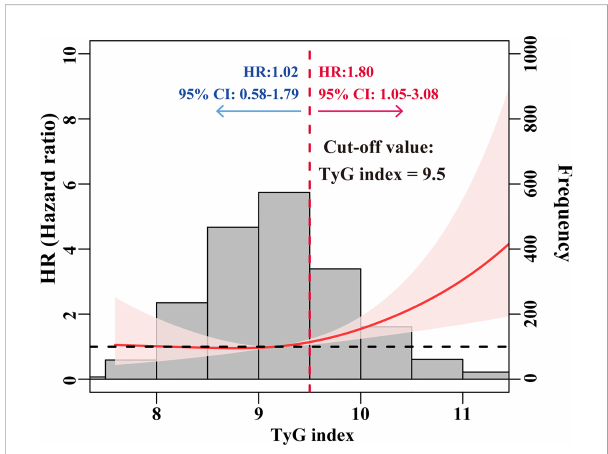
FIGURE 2 HRs for the risk of ESRD by baseline TyG index. The red solid line represented unadjusted HRs of the baseline TyG index across the whole range. The black dot line represents the reference line when HR = 1. The frequency distribution of the baseline TyG index is shown by histograms.